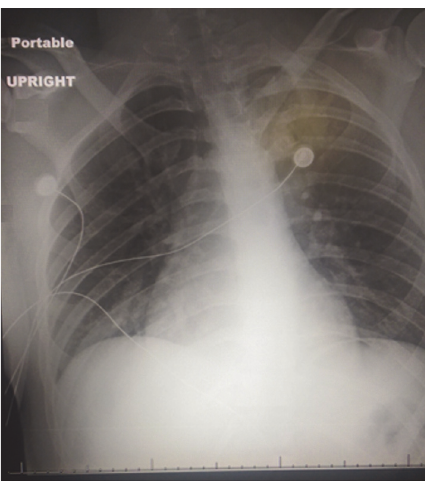
Figure 1: Anterior-posterior chest radiograph showing no obvious abnormalities in the thoracic cavity.